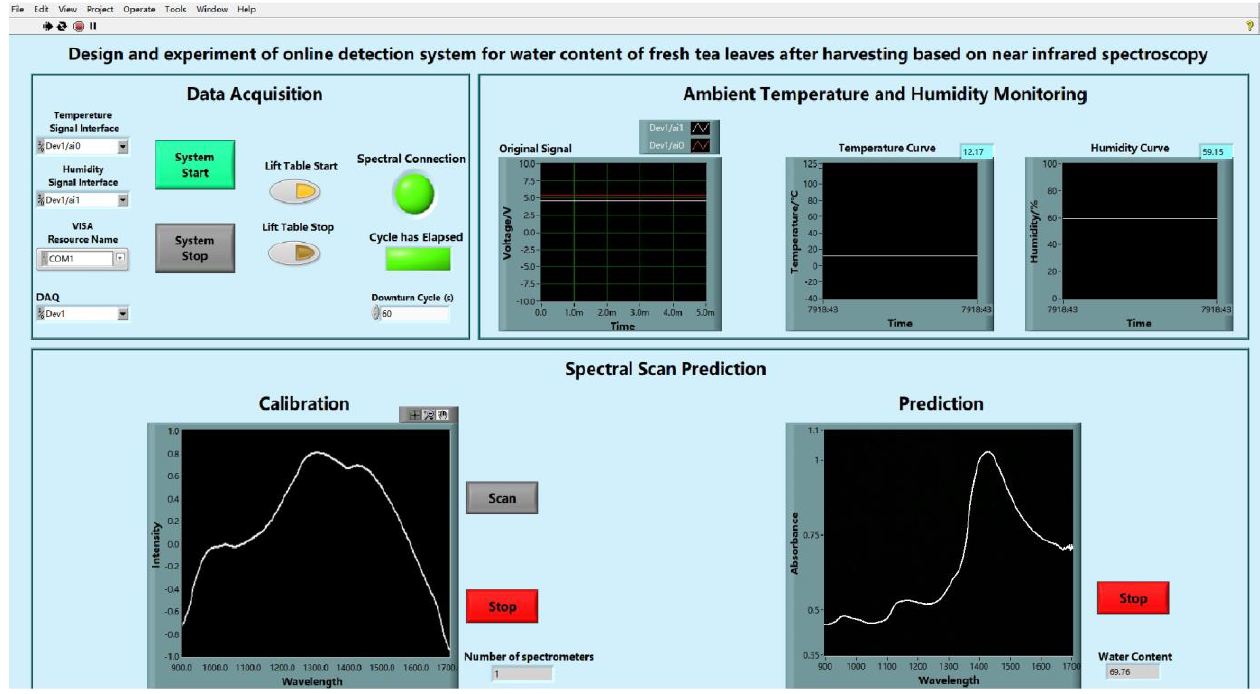
Figure 7. Labview upper computer online detection system interface.